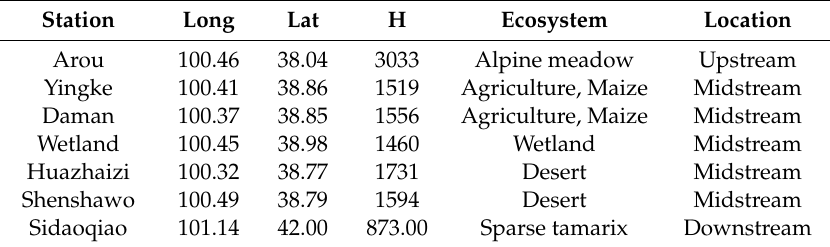
Table 1. List of fields station in the Heihe River Basin used in this study.